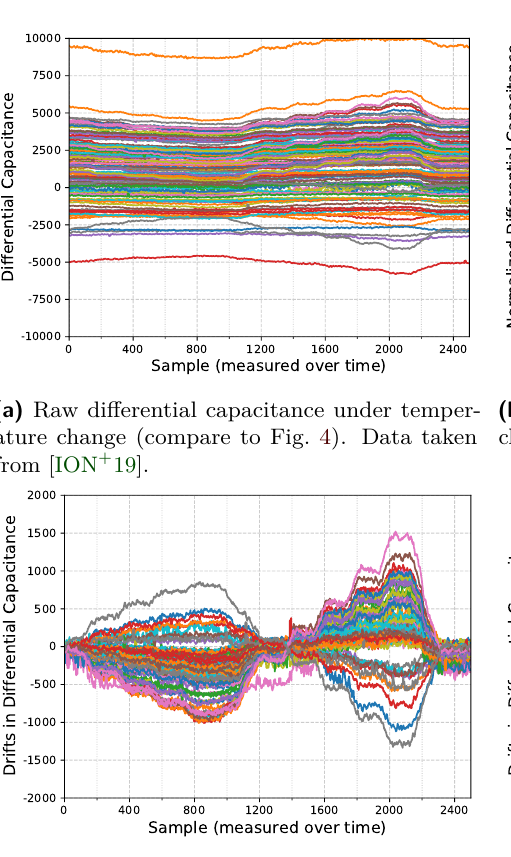
(c) Change in differential capacitance due to tem- perature changes compared to reference measure- ment (at 20 ◦ C) before Tx group shift.